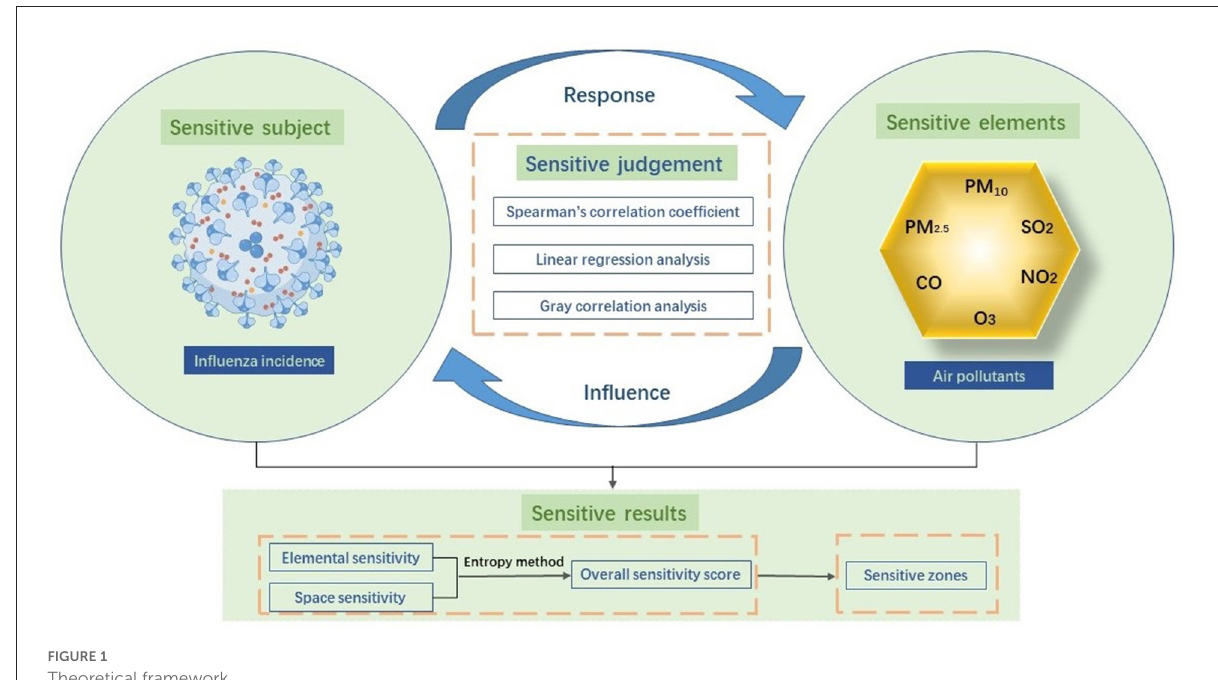
FIGURE1 Theoretical